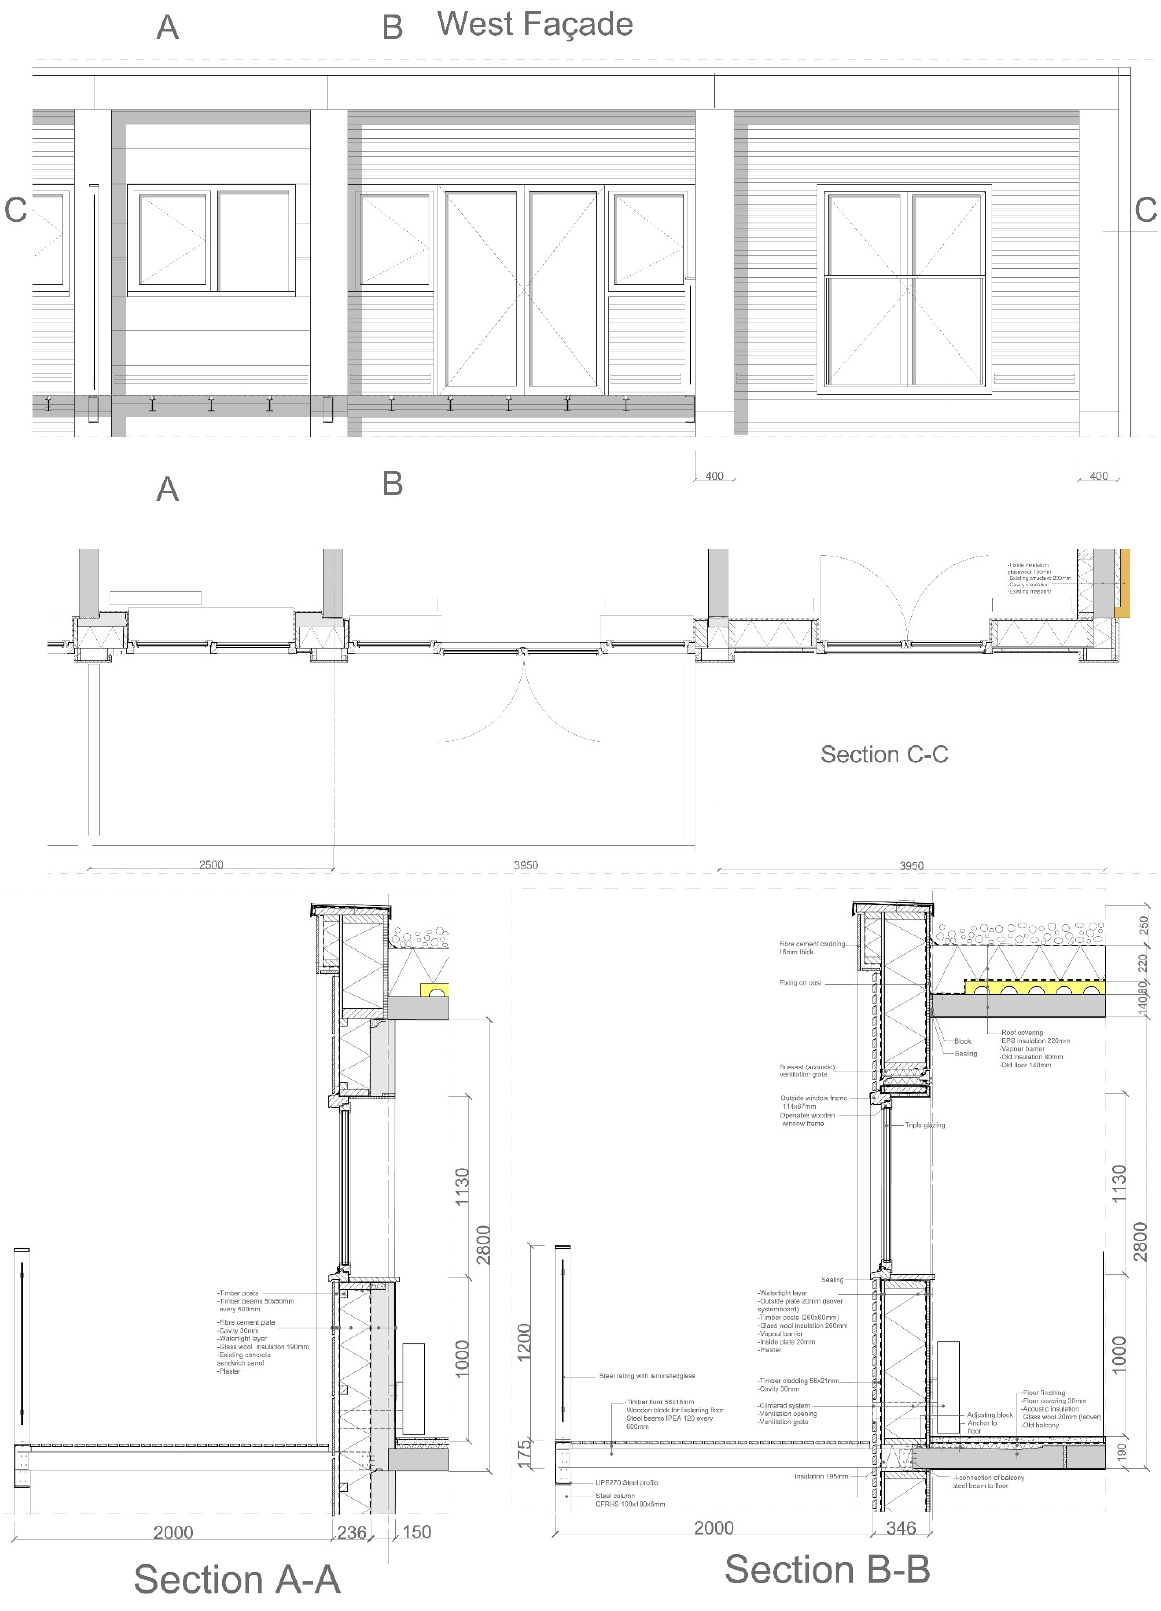
Figure 14. West façade and detailing of the top corner apartment of the new design. The east façade is comparable to the west